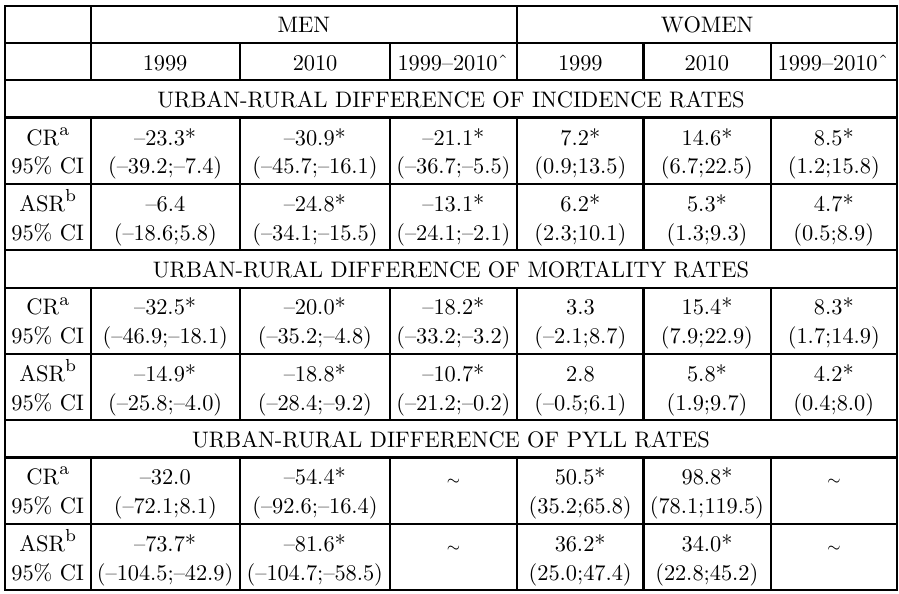
Table 4. Urban-rural difference of lung cancer incidence. Mortality and PYLL rates from 1999–2010 in the Świętokrzyskie Province MEN